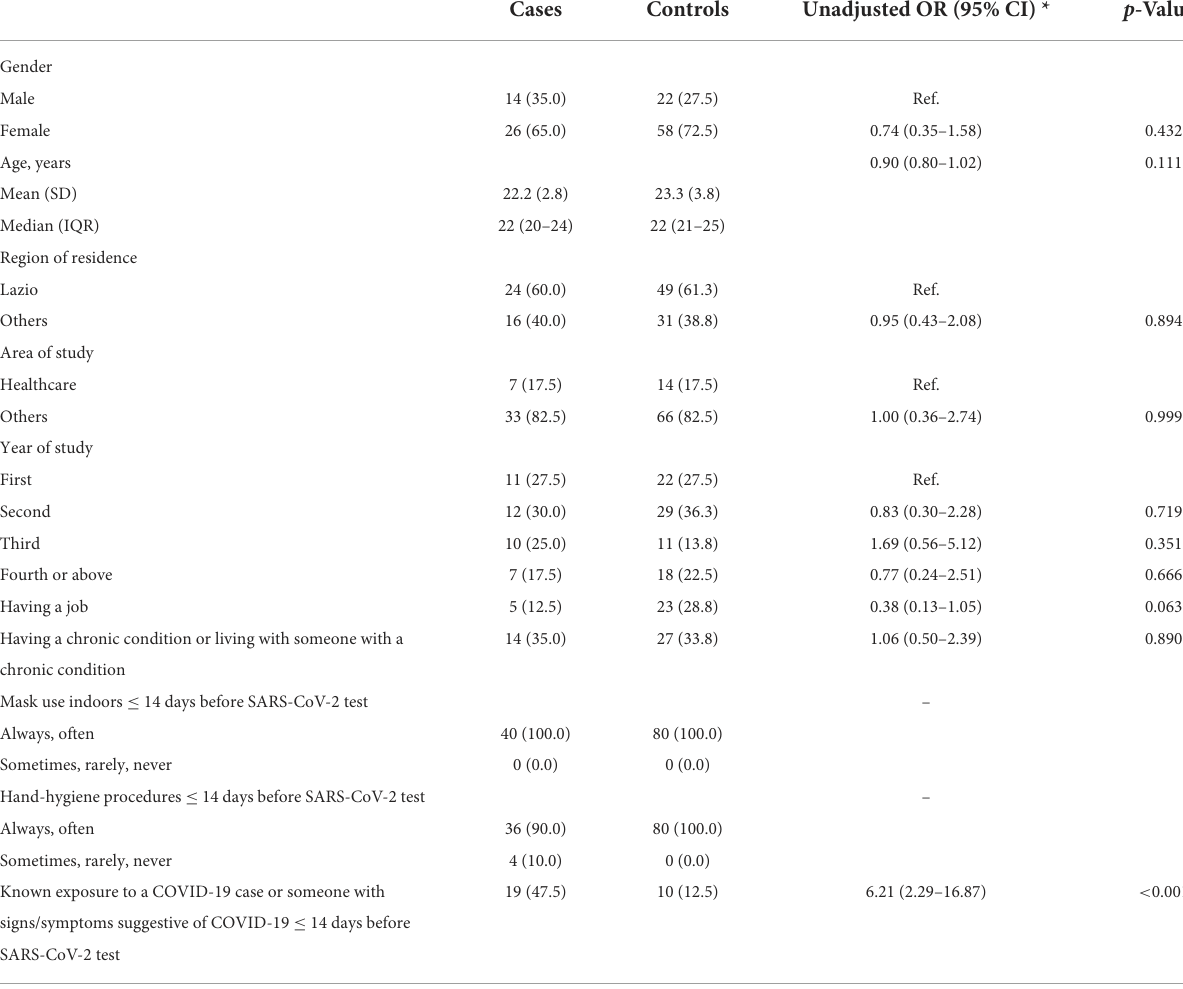
TABLE 2 Students’ sociodemographic characteristics and self-reported adherence to precautionary measures.